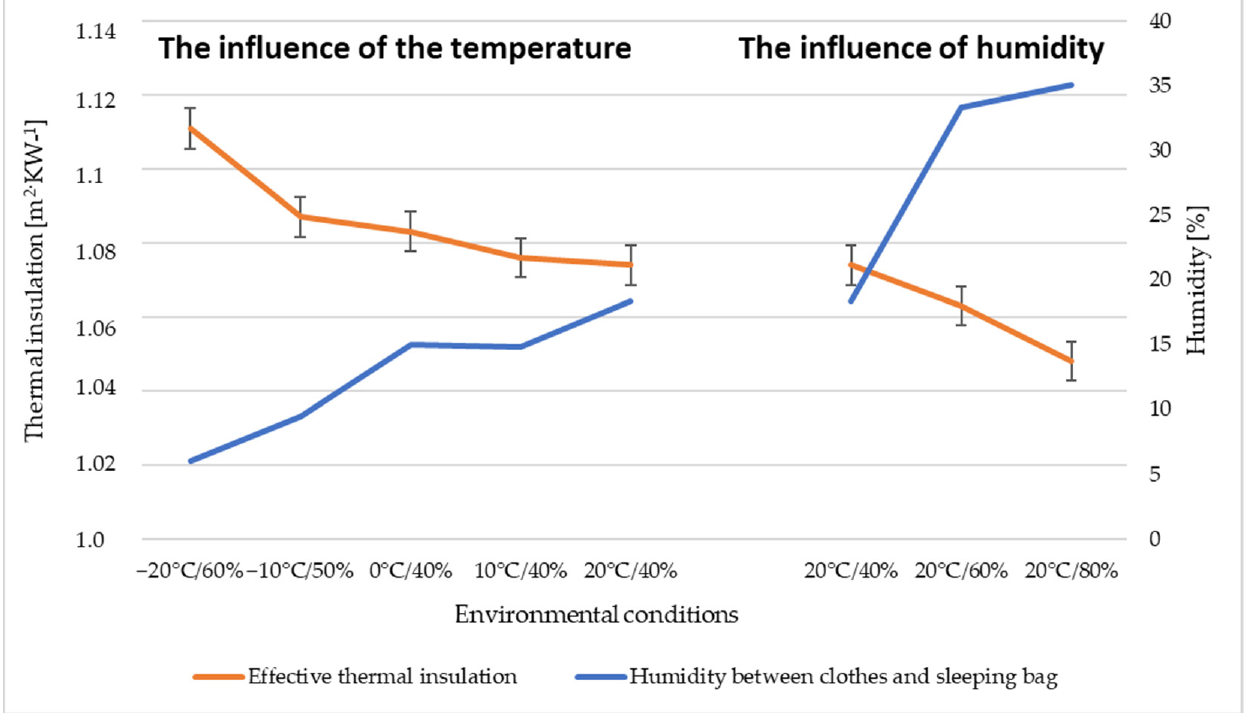
Figure 10. Thermal insulation of a mannequin in an autumn sleeping bag.